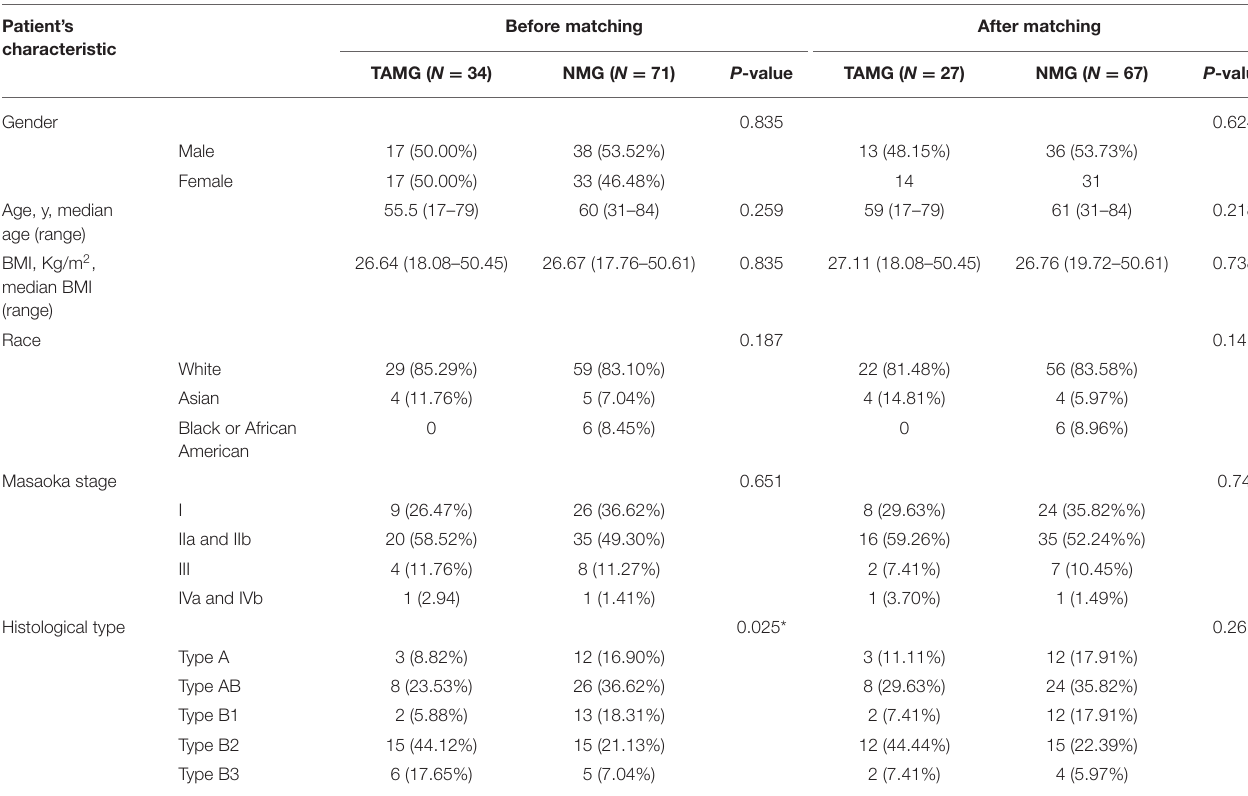
TABLE 1 | Demographic information before and after propensity score matching. Patient’s